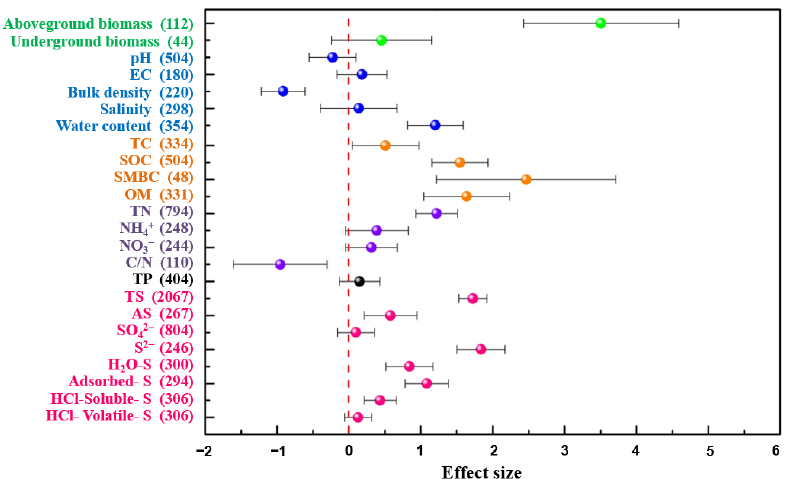
Figure 2. Effects of S. alterniflora invasion on soil properties. The x-axis is the SMD of each variable in invaded vs. native areas. The vertical line was drawn at SMD = 0. The numbers of observations are shown in parentheses. EC, electrical conductivity; TC, total carbon; SOC, soil organic carbon; SMBC, soil microbial biomass carbon; OM, organic matter; TN, total nitrogen; TP, total phosphorus; TS, total sulfur; AS, available sulfur.